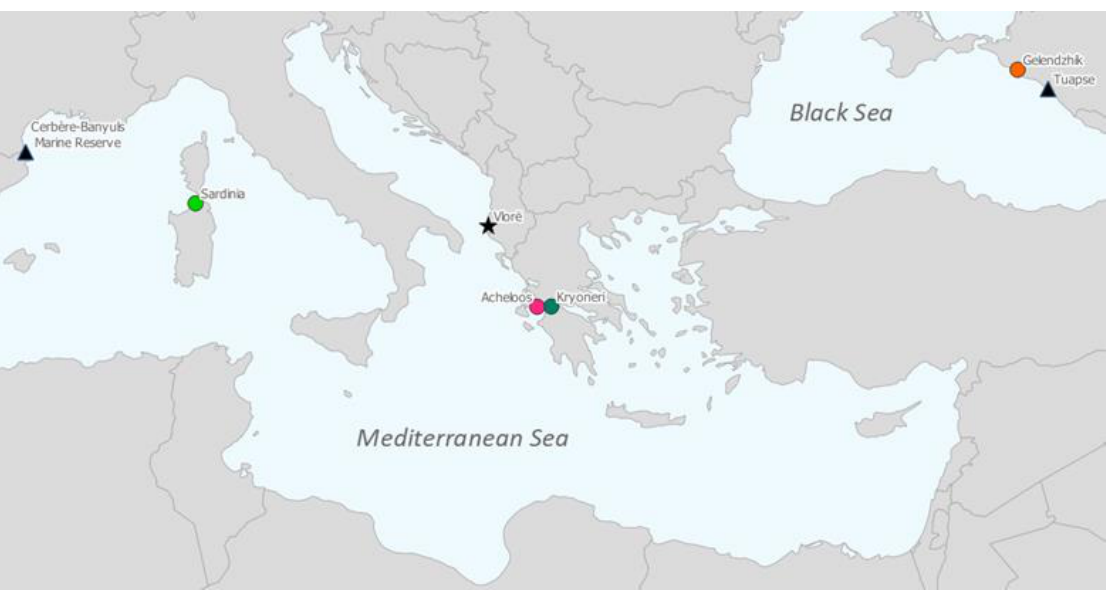
Figure 4. Distribution of Xenoligophoroides cobitis . Star: type locality, Gulf of Vlorë, Albania. Triangles: previously published records without accompanying genetic data (overview: see [17] and references therein). Green: population from northwestern Sardinia, Italy; orange: population from Gelendzhik, Russia, both sequenced by Dmitrieva et al. [17]. Pink: population from the Acheloos Delta, Greece; turquoise: population from Kryoneri Estuary, Greece, both sequenced in the present study. Colors correspond to those in the haplotype network (Figure 3).